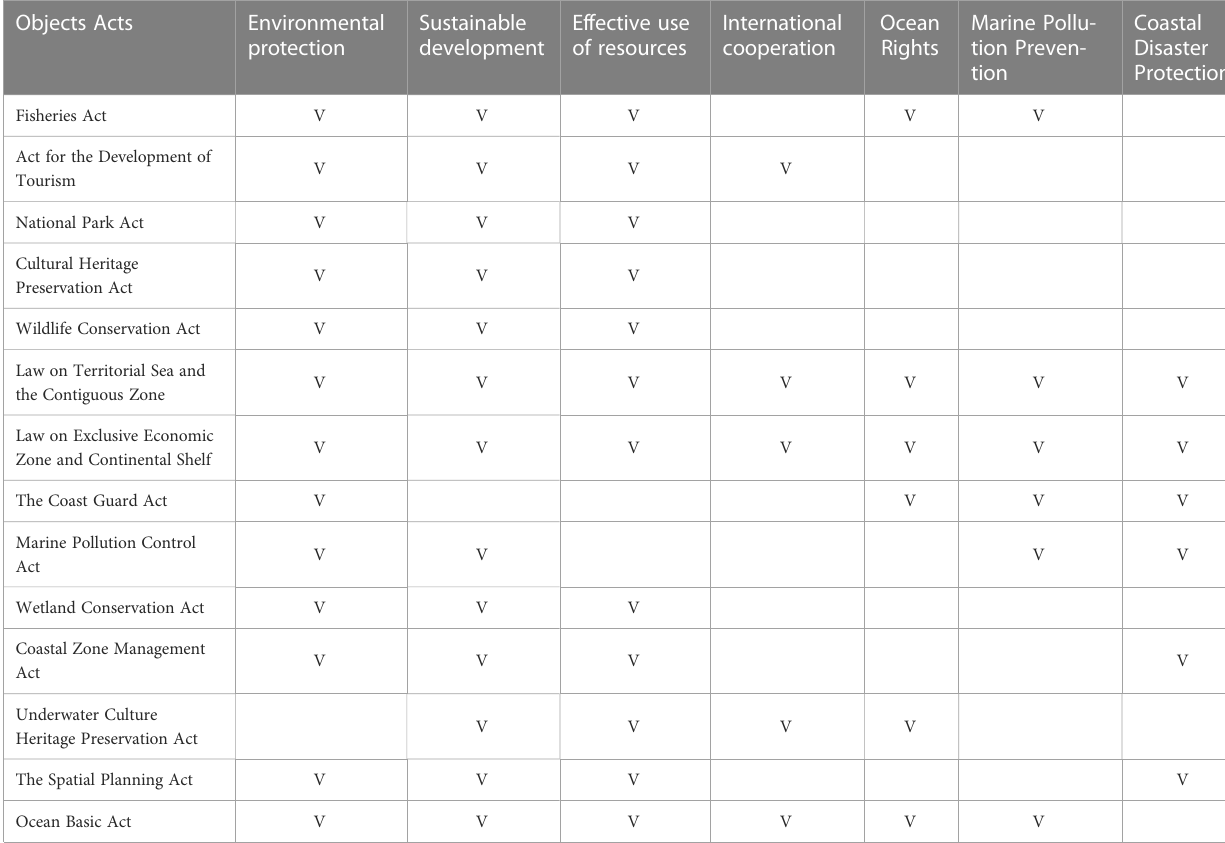
TABLE 2 Core functions of the ocean-related